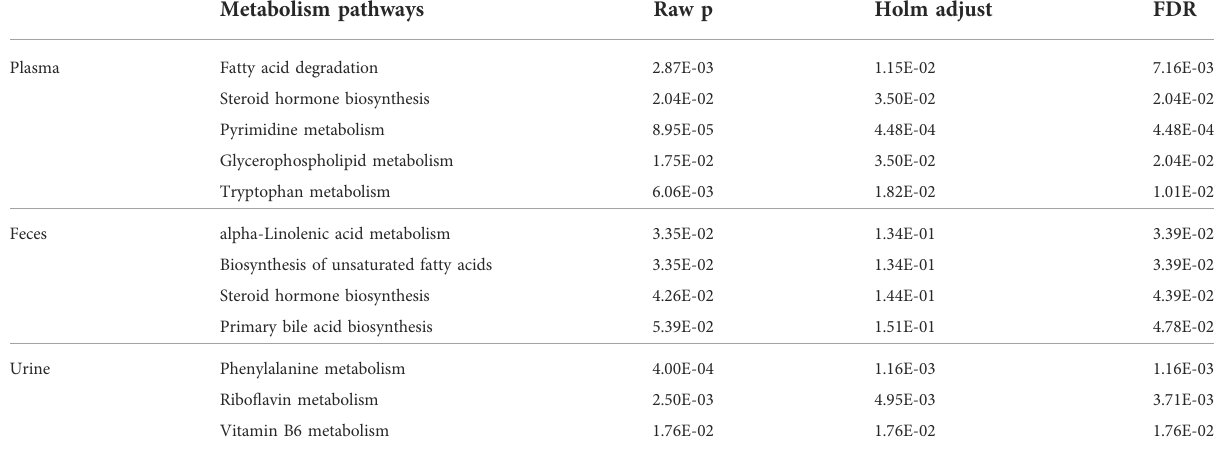
TABLE1Pathwayanalysisofdifferentialmetabolitesidenti fi edbetweencontrolandHAUgroupsrats.Rawpistheoriginal p valuecalculatedfromthe enrichmentanalysis;theHolmpisthe p valueadjustedbyHolm-Bonferronimethod;theFDRpisthe p valueadjustedusingFalseDiscovery